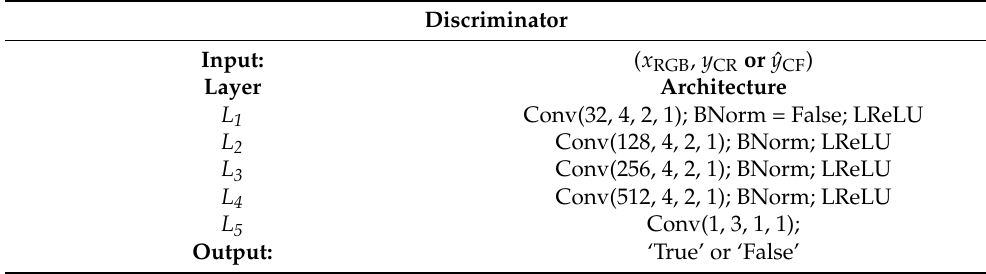
Table 1. Architecture of the discriminator.